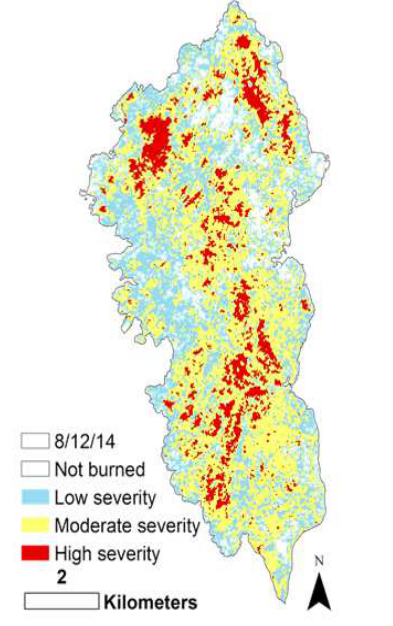
Figure 1. Soil burn severity map for the French Fire in California, the pre-fire image was collected by Landsat 8 on July 26, 2014 and the post-fire image was collected by the Earth Observing-1 Advanced Land Imager on August 9,